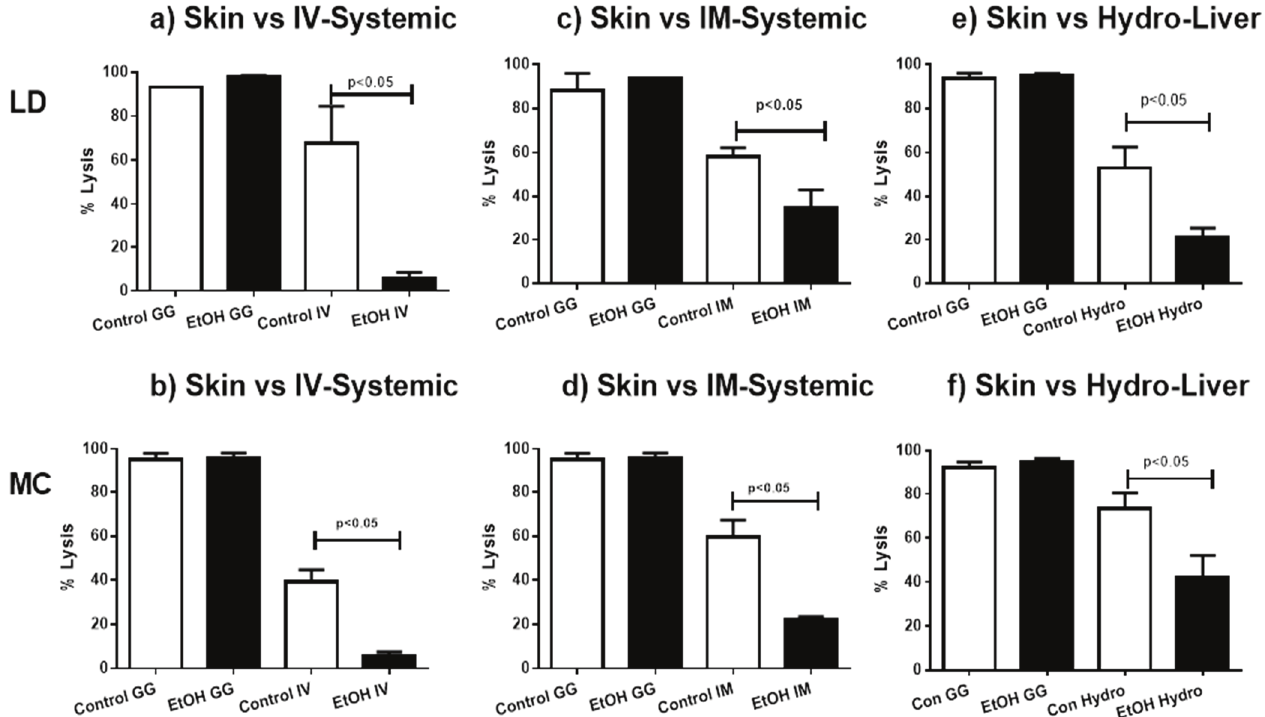
Figure 4. Skin Immunization Obviates EtOH Induced Inhibition of CTL Induction .